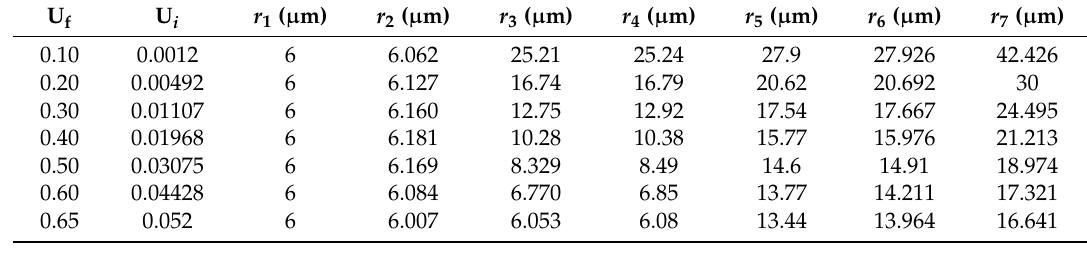
Table 1. Radii of the seven-phase cylindrical model versus filler content.